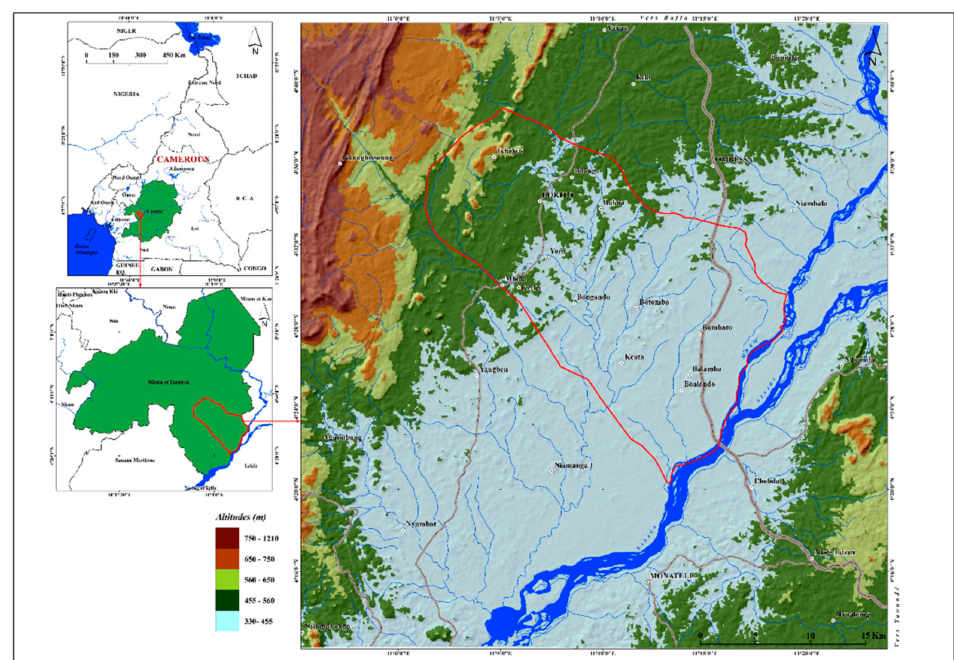
Figure 1. Location of the study area.